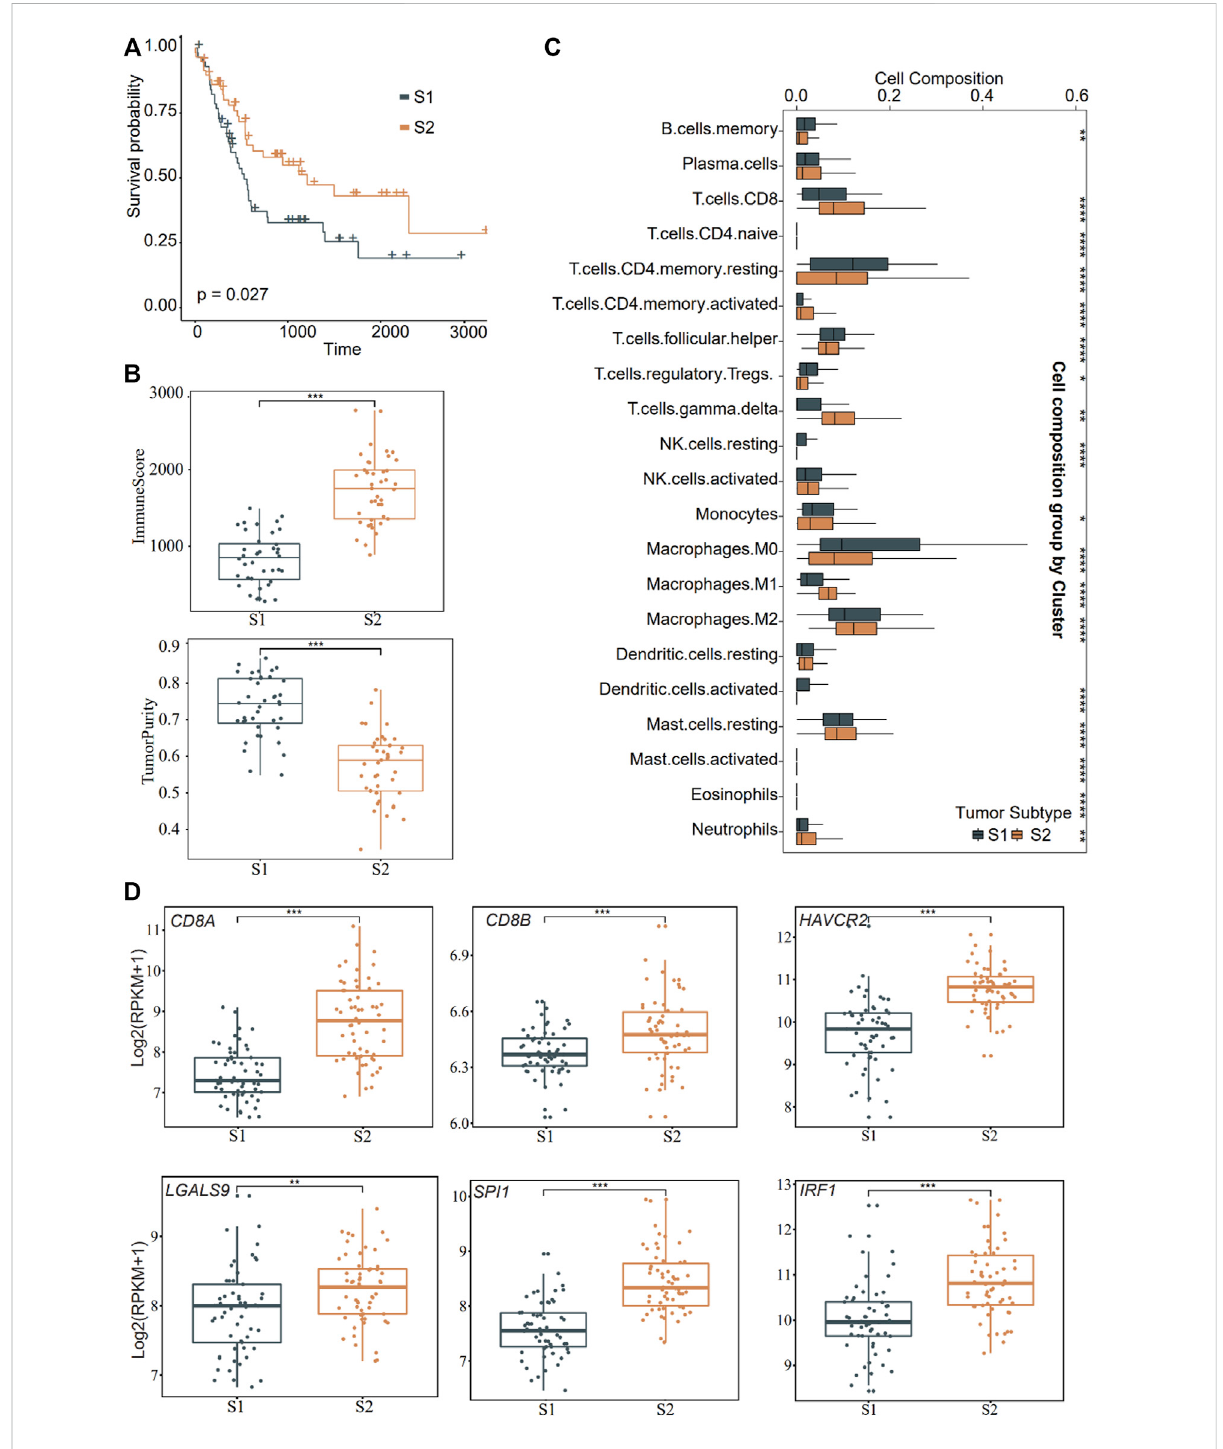
FIGURE 4 Distinct function in the two subtypes of CCA. (A) Overall survival curves showing the prognosis result of the two subtypes (S1 and S2) obtained from consensus clustering in CCA cohort (GSE89749) using thegenes obtained from eLBP. Statisticalsigni fi cance was calculated using thelog-rank test. (B) Box plots showing the immune and tumor purity scores in the two distinct malignant subtypes (*** p < 0.001). Pairwise comparison was conducted by Wilcoxon rank sum test. (C) Box plots showing the 22 immune cell in fi ltrates ratio in the two distinct malignant subtypes in the signi fi cant enrich patients. (* p < 0.05; ** p < 0.01; *** p < 0.001; Wilcoxon rank sum test). (D) Comparisons of gene expression level of immune genes in the two distinct malignant subtypes (** p < 0.01; *** p < 0.001; Wilcoxon rank sum test). For the boxplot, the centerline, median; box limits, upper and lower quartiles. Each dot represents a